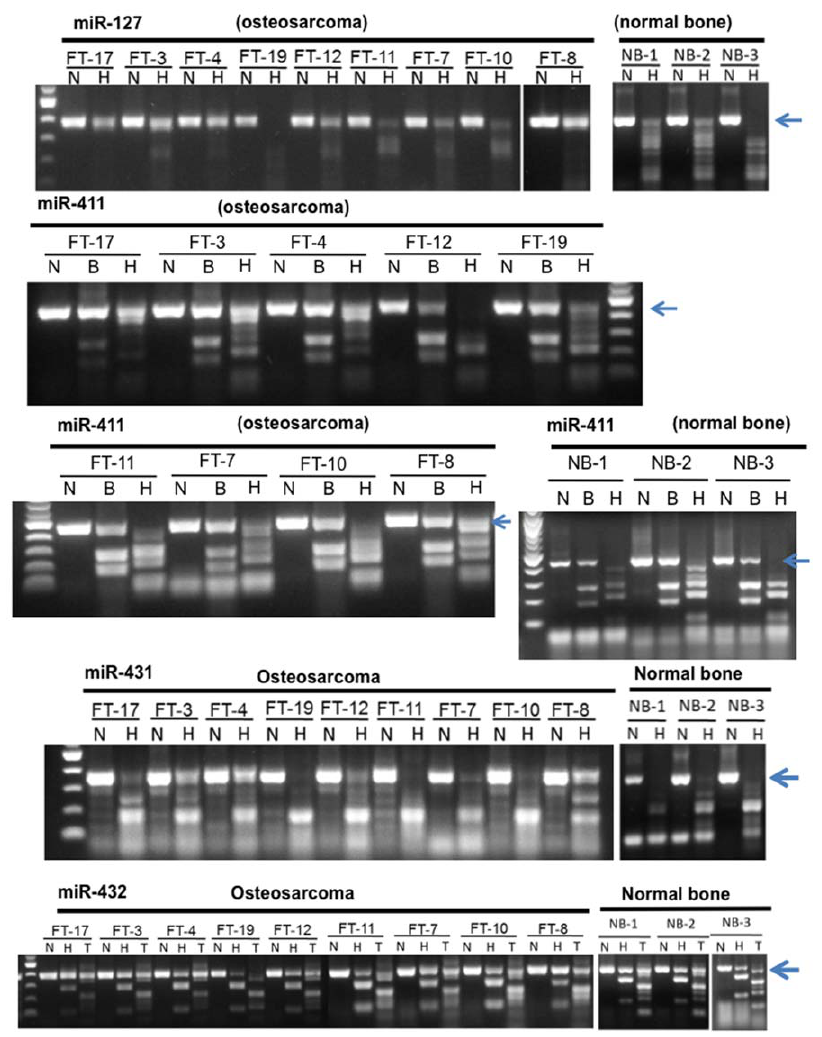
Figure 1. COmbined Bisuifite Restriction Analysis (COBRA) for CpG regions upstream of miR-127, -411, -431 and -432 in OS and normal bone tissue samples. The following enzymes were used as indicated (B- Bst UI; H- Hpy CH4IV; T- Taq I; N- no enzyme). Bisulfite conversion of methylated CpGs created new restriction sites and the level of digestion of the bisulfite converted PCR product with listed enzymes was directly related to its intrinsic methylation, hence indicative of level of DNA methylation. As a reference for normal DNA methylation status, identical analysis for each region was performed with DNA from normal bone tissues. Relative difference in the digestion insensitivity of the PCR product (marked by arrow) in OS patients relative to normal bone tissue was indicative of similar or relative hypomethylation of these loci in OS patients.